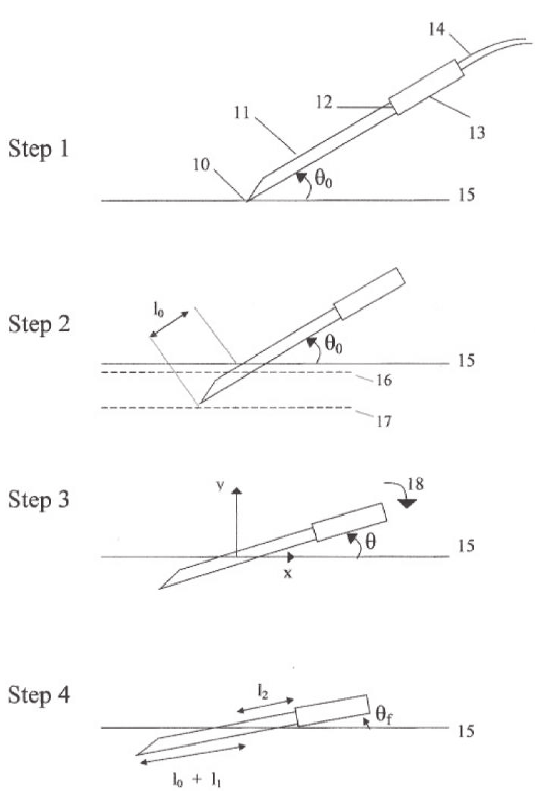
Figure 1: A side profile view of the peripheral venepuncture